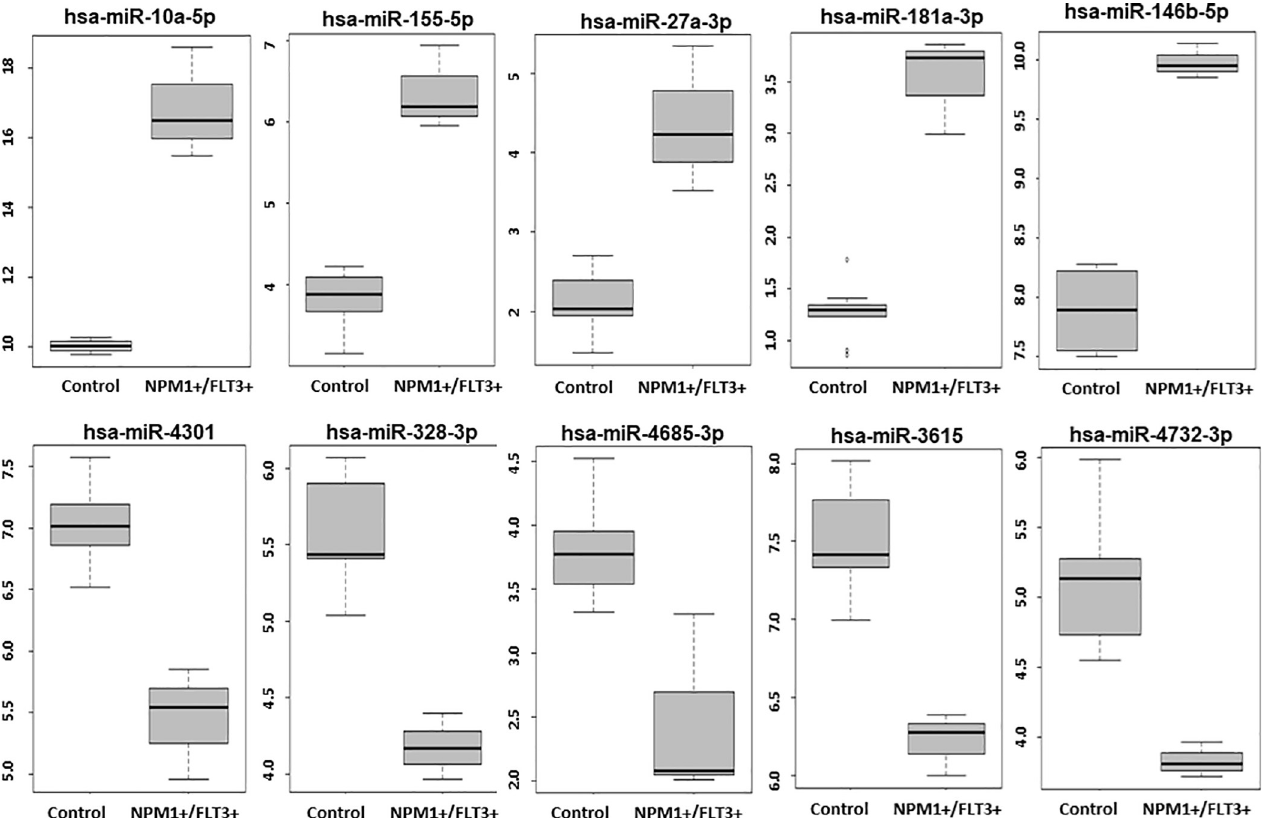
Fig 2. Boxplots showing relative expressions levels of ten miRNAs with statistically significant difference between control and AML NPM1+/FLT3 + patient samples.